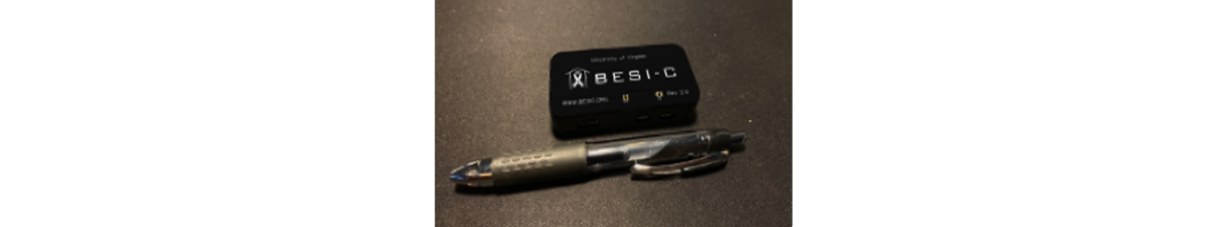
Figure 3. Behavioral and Environmental Sensing and Intervention for Cancer (BESI-C) updated environmental sensor based on user design